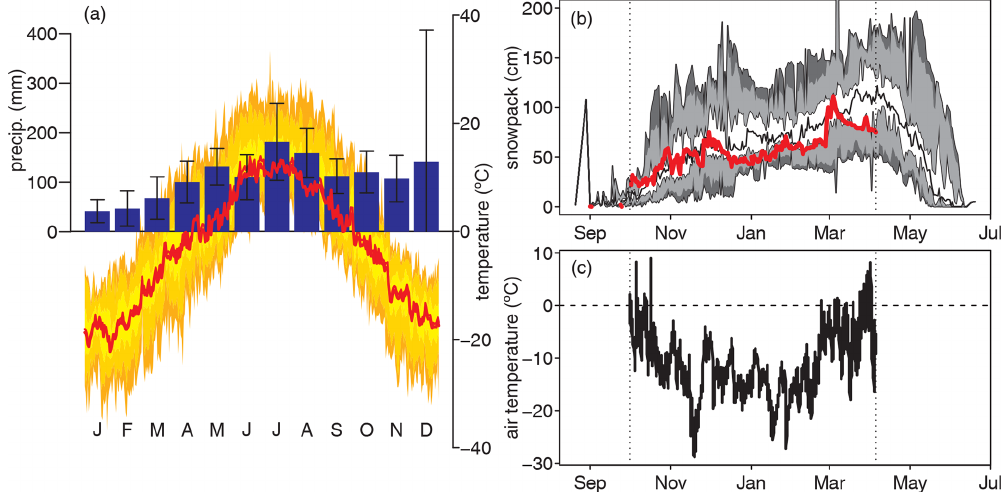
Figure 2. Records at the Olenya Rechka Meteorological Station. (a) Climograph (1 February 2005–30 April 2019). The median yearly precipitation was 1242.975mm, with winter (2 October to 5 April) and summer precipitations of 464.95 and 778.025mm, respectively. Temperature: median (red), interquartile range (yellow band), 5th to 25th percentiles and 75th to 95th percentiles (lower and upper golden bands), and below the 5th percentile and above the 95th percentile (lower and upper orange bands). (b) Snowpack thickness (2005–2017): median (black), interquartile range (white band), 5th to 25th percentiles and 75th to 95th percentiles (lower and upper light gray bands), and below the 5th percentile and above the 95th percentile (lower and upper dark gray bands). The red line corresponds to the 2016–2017 snowpack thickness record until the snow sampling date. (c) Air temperatures measured every 3h during the time period when analyzed snowpacks were laying on their respective locations (2016–2017). Table 1. Sampling sites and distance to local perturbations. Temporary summer camps are present on the shore of Lake Svetloe and used to be on that of Lake Raduzhnoe. See Table S1 from Diaz-de-Quijano et al. (2020) for lake and watershed cover